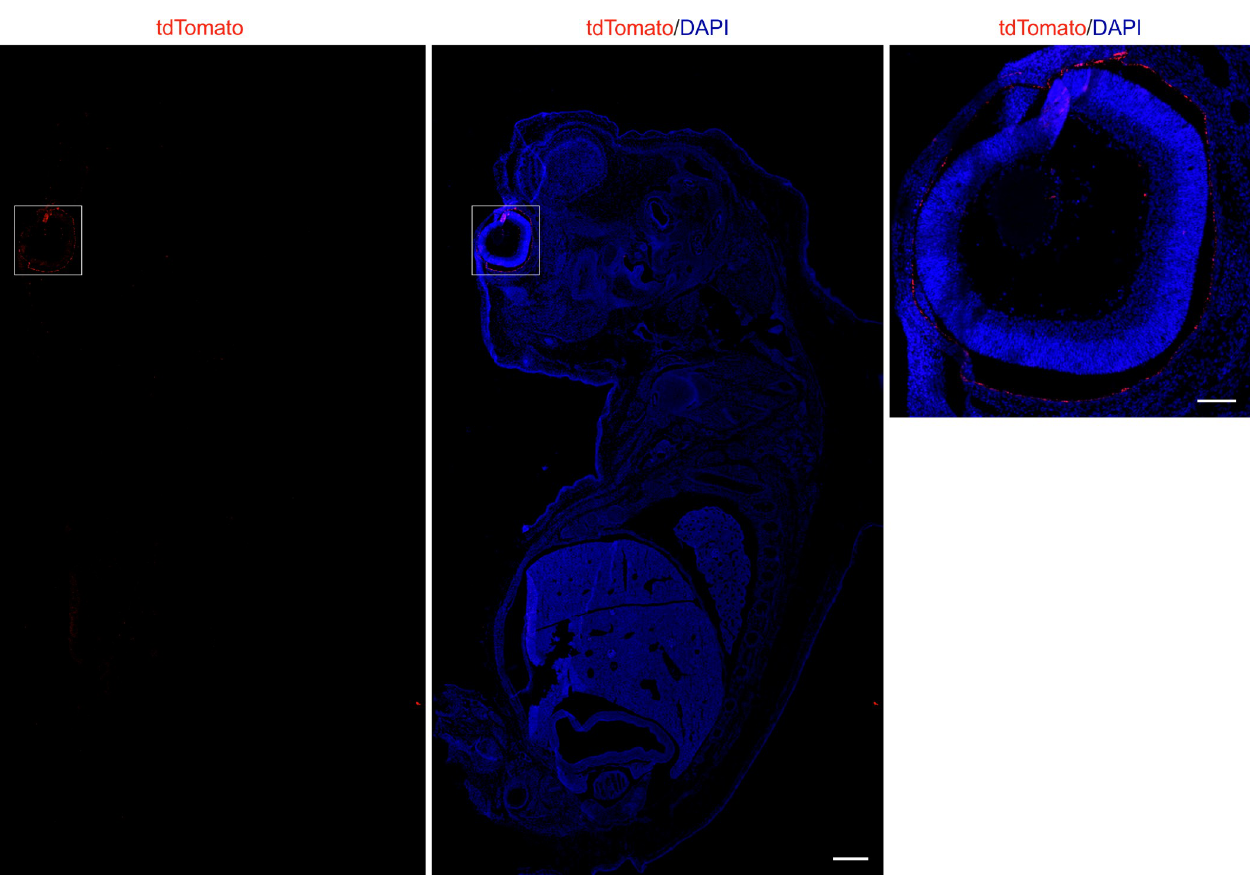
Fig 3. Cre-mediated recombinant expression in an Ai14;RPE-Tyrosinase-CreEr T2 embryo section. A: Fluorescent image of tdTomato expression in longitudinal embryo sections stained with DAPI (blue) showing that Cre activity is restricted to the eye. B: Higher magnification of the eye region in A shows high specificity for the RPE. Scale bar: (A) 500 μ m, (B) 100 μ m.